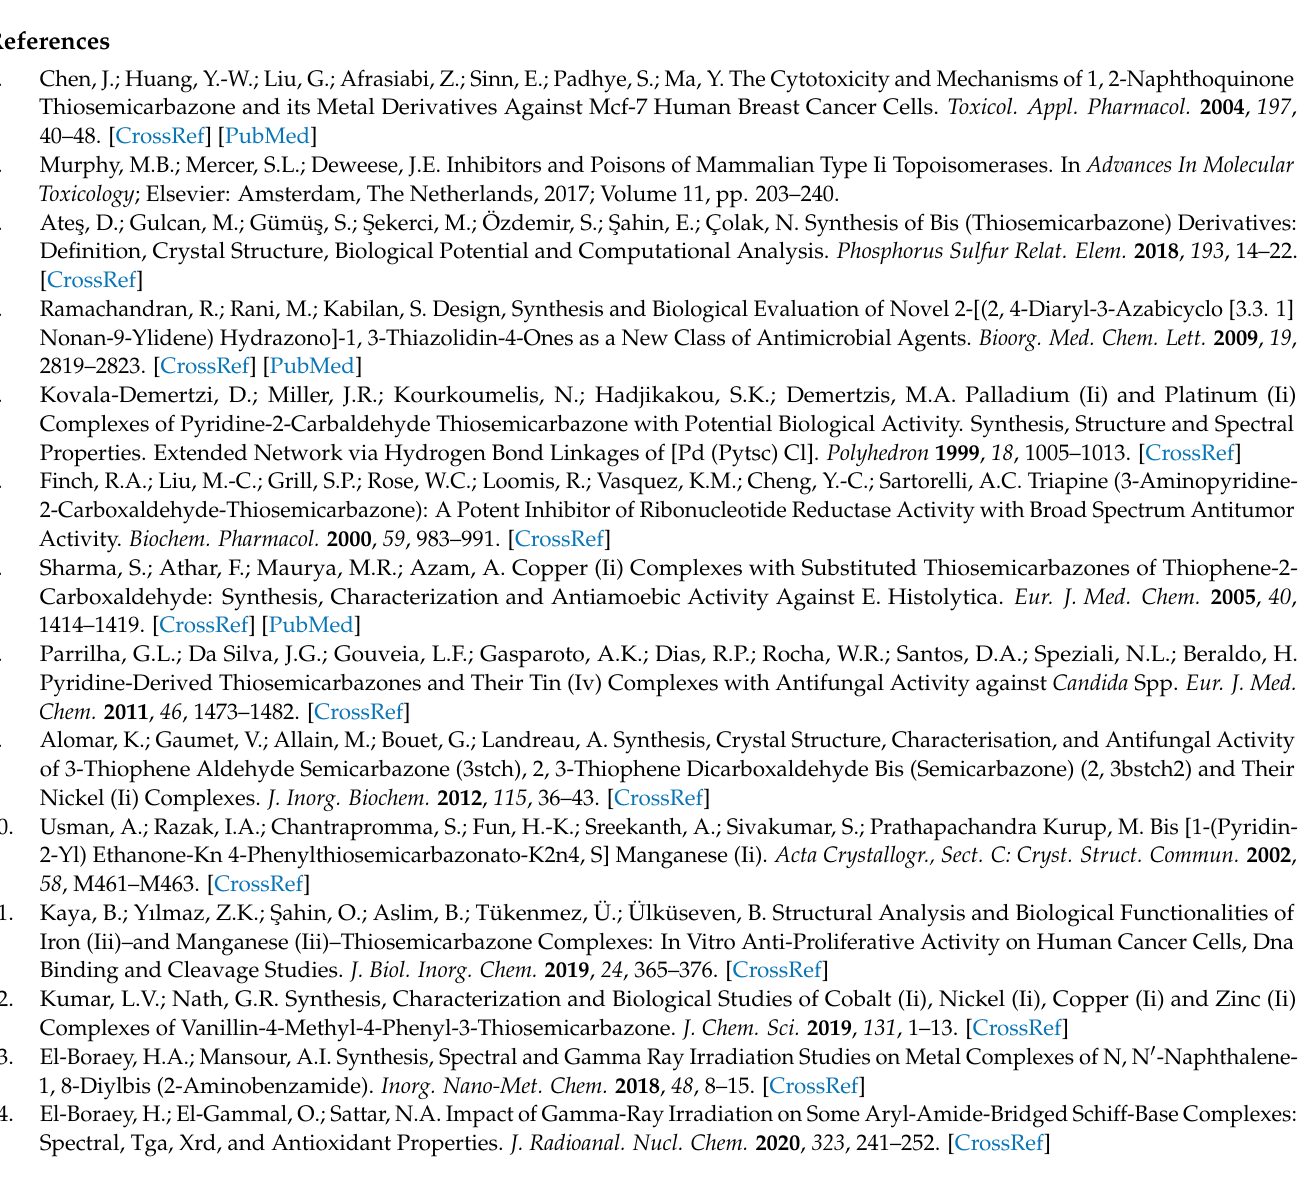
Table S6: Antimicrobial activity of unirradiated and irradiated